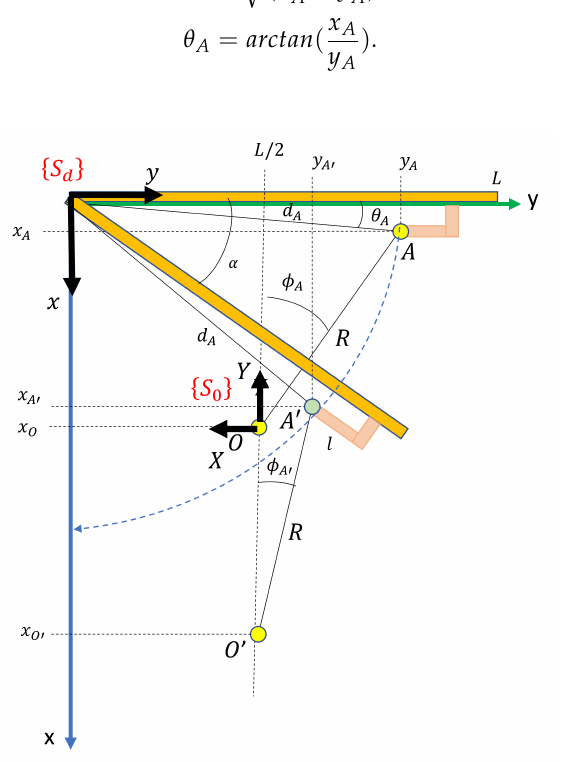
Figure 11. Pulling the door. Reference frames and parameters in initial and intermediate